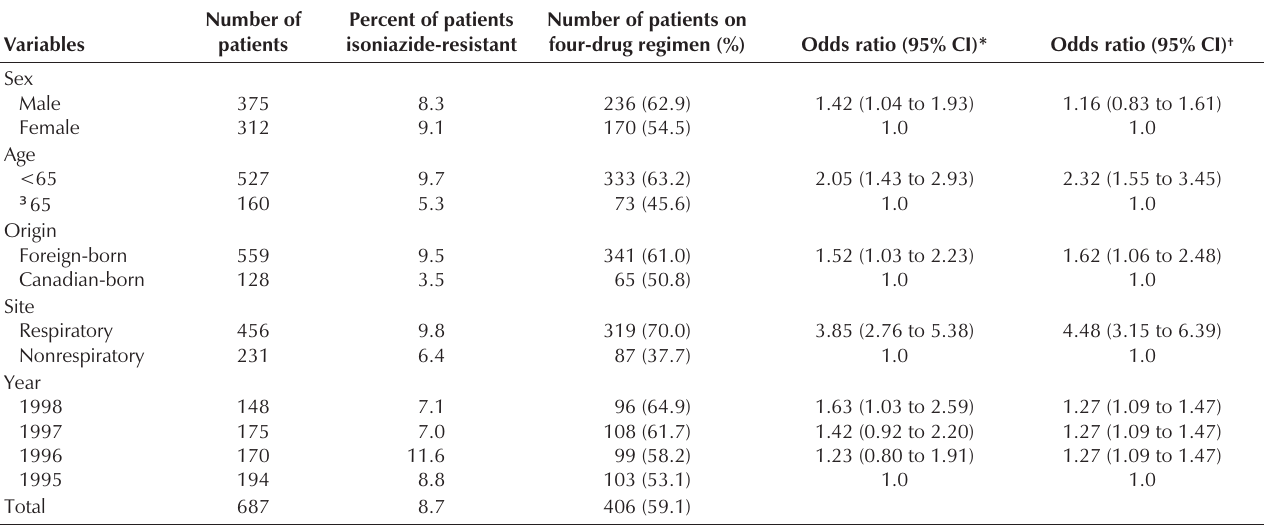
*Univariate analysis; † Multivariate analysis